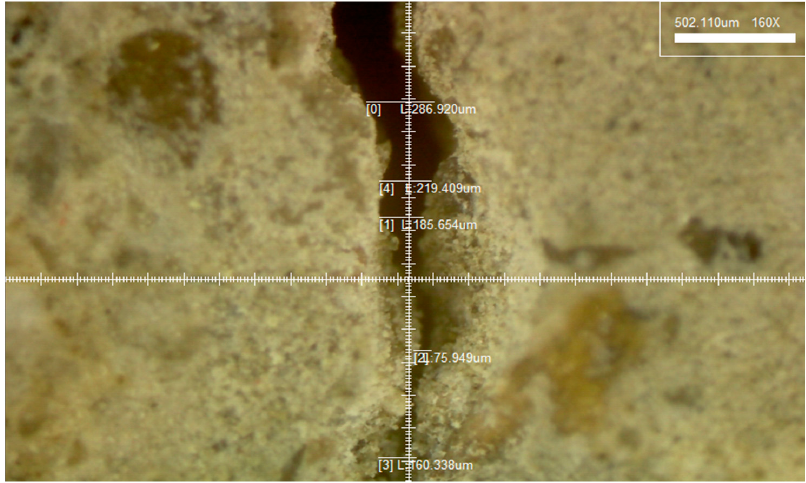
Figure 4. Measured microcracks by microscope.